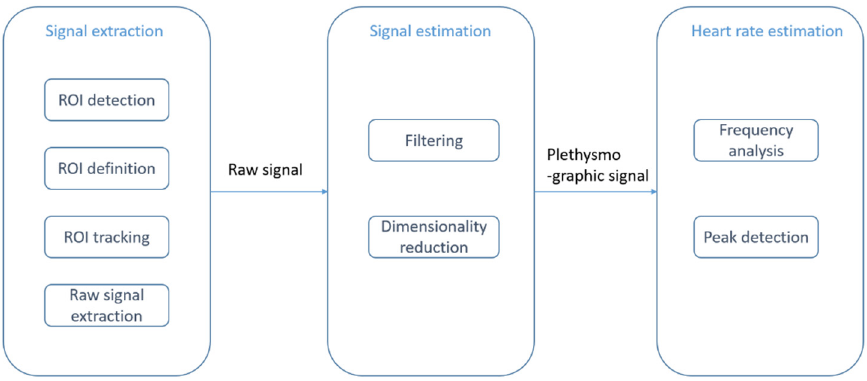
Figure 3. rPPG or contactless PPG image processing framework: signal extraction step (ROI detec- tion and tracking), signal estimation step (filtering and dimensionality reduction), and heart rate estimation step (frequency analysis and peak detection).